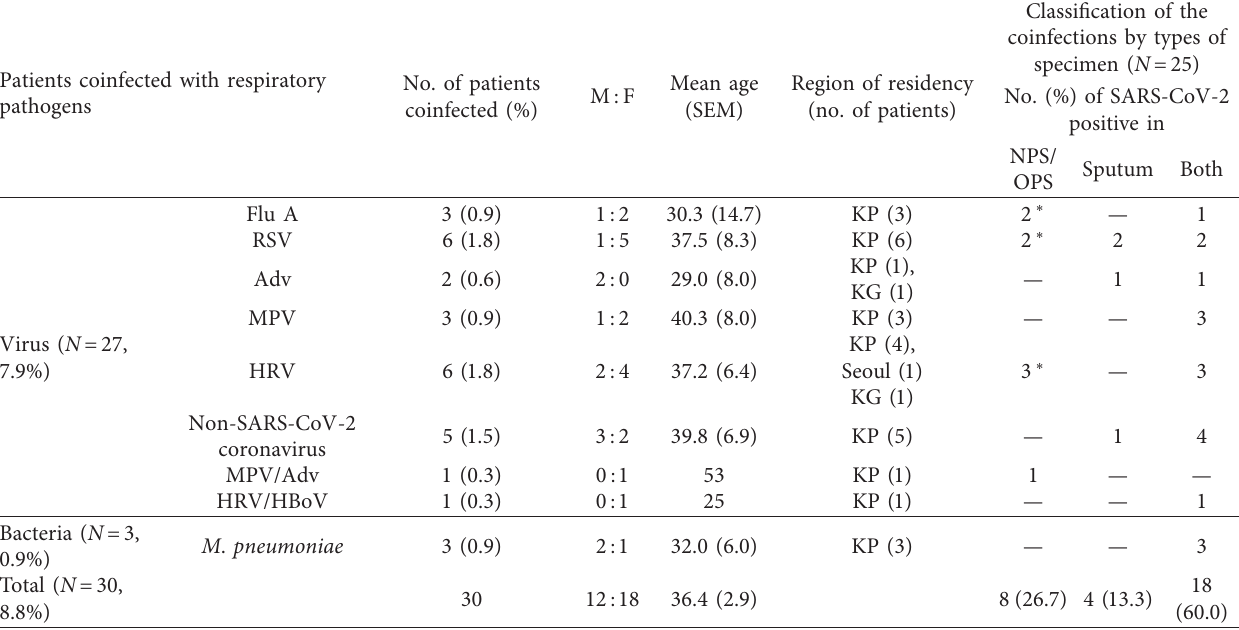
Table 1: Study subjects ( N � 342) with COVID-19 coinfected with respiratory pathogens.